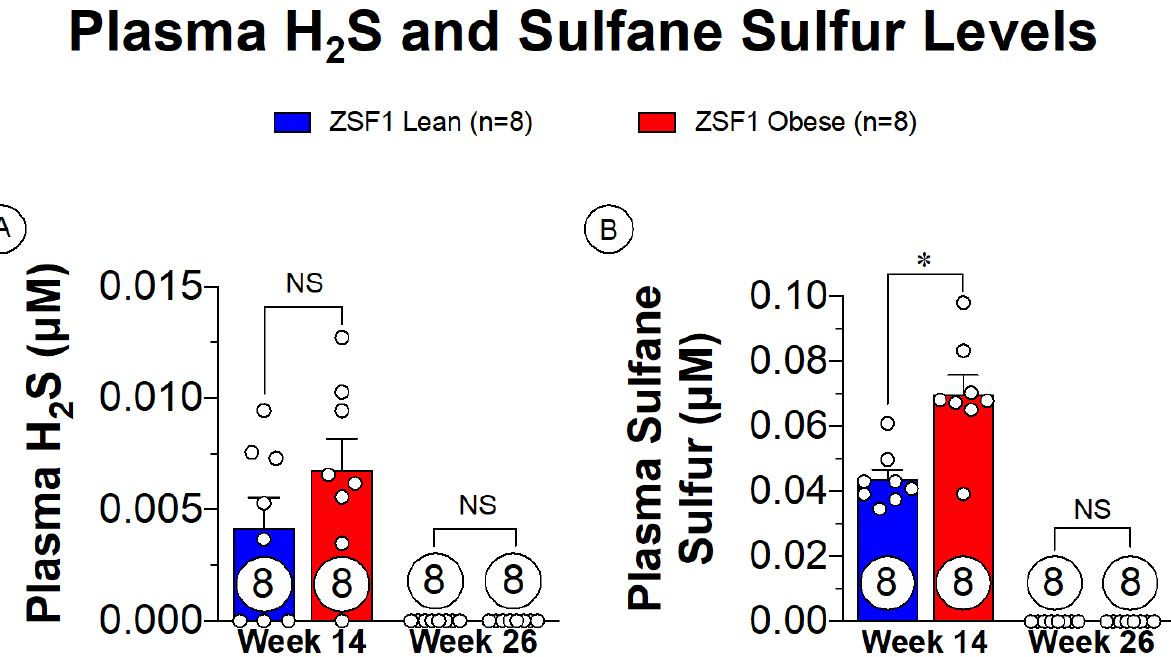
Figure 3. Plasma free H 2 S and sulfane sulfure levels in ZSF1 obese rats prior at multiple time points in disease progression. ( A ) Plasma H 2 S levels at 14 weeks of age (prior to HFpEF onset) and at 26 weeks of age (late-stage HFpEF). ( B ) Plasma sulfane sulfur levels at 14 and 26 weeks of age. NS: Not Significant, * p <